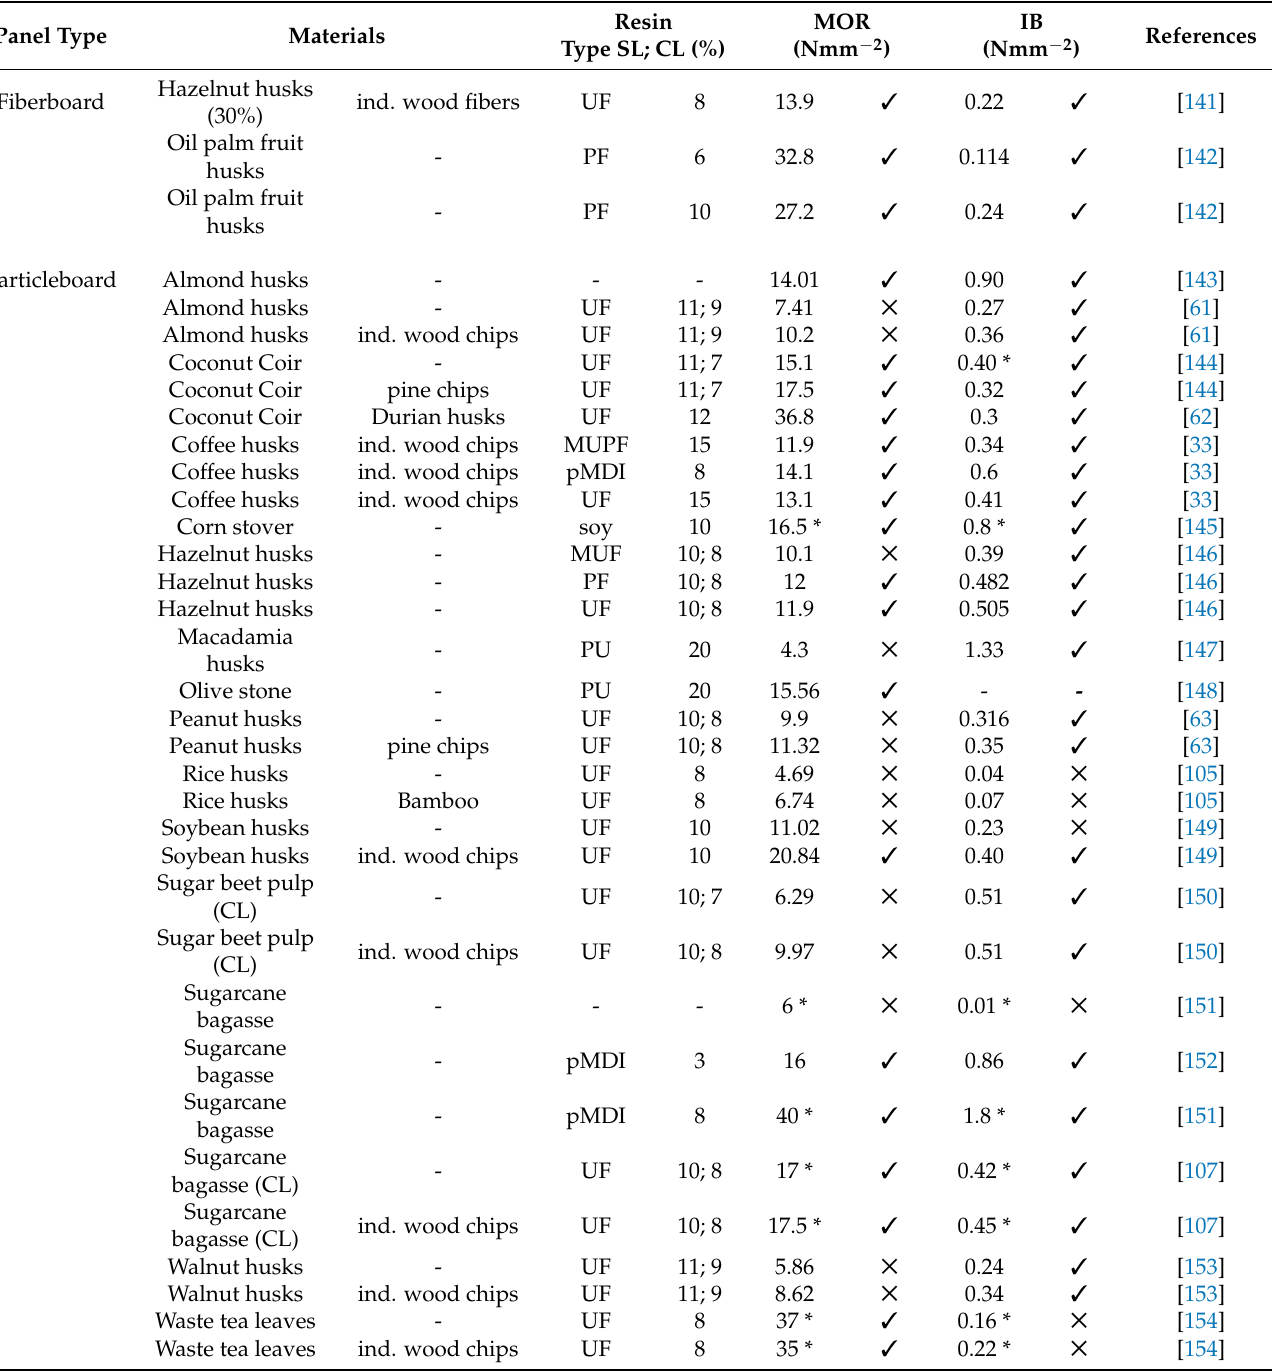
Table 8. Process residues used for panel with information on whether MOR and IB meet ( (cid:51) ) or not ( (cid:53) ) the standard requirements (fiberboard EN 622-3:2004; particleboard EN